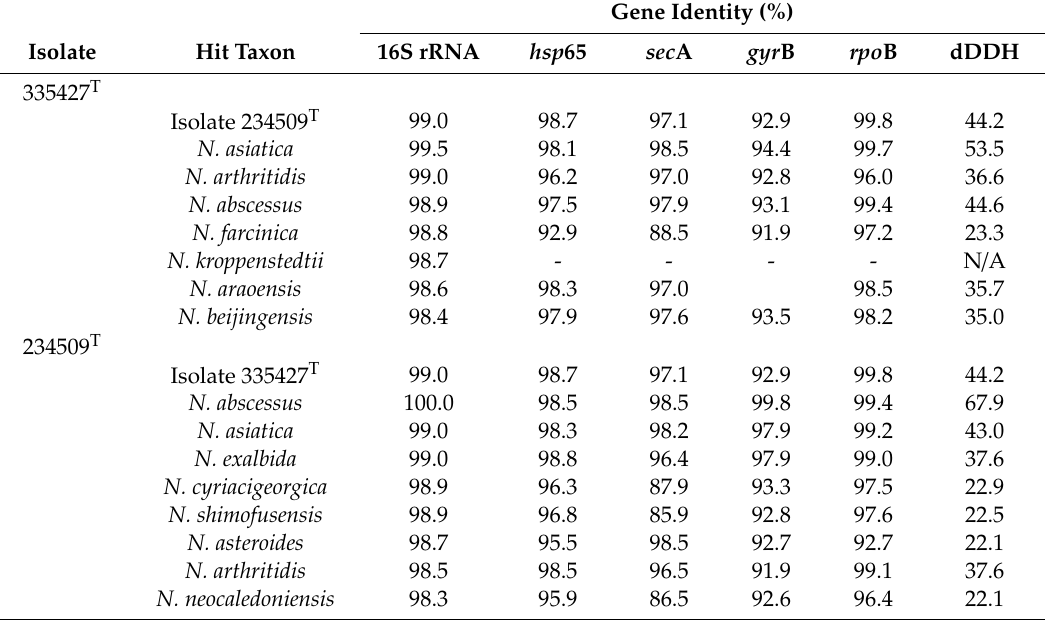
Table 2. 16S rRNA and housekeeping genes similarity as well as the digital DNA–DNA hybridization (dDDH) values c / o between isolates 335427 T and 234509 T and their closest phylogenetic relatives. Gene Identity (%) Isolate Hit Taxon 16S